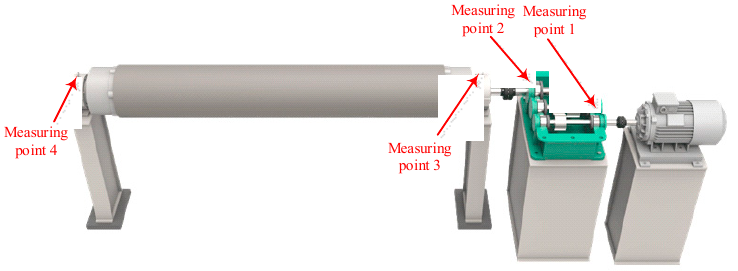
Figure 10. Three-dimensional schematic of the engineering object with the layout of measuring points.